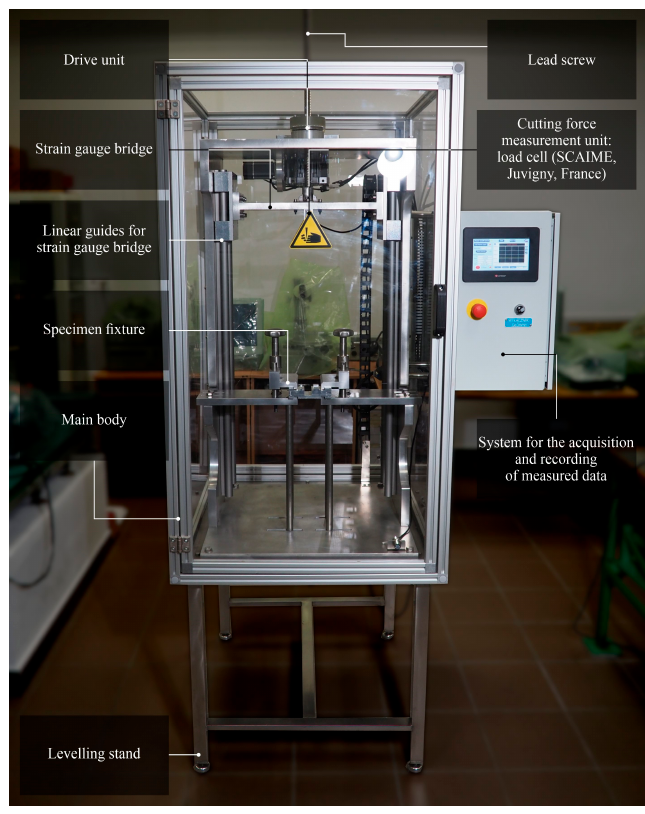
Figure 1. General view of the measuring station.